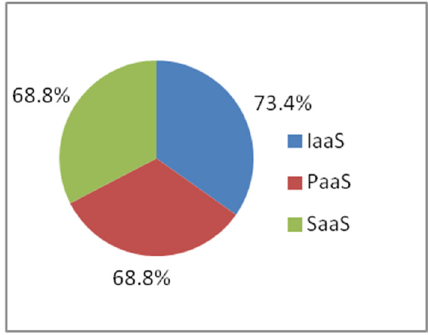
Figure 18. Cloud ERP (C-ERP) service models adoption.